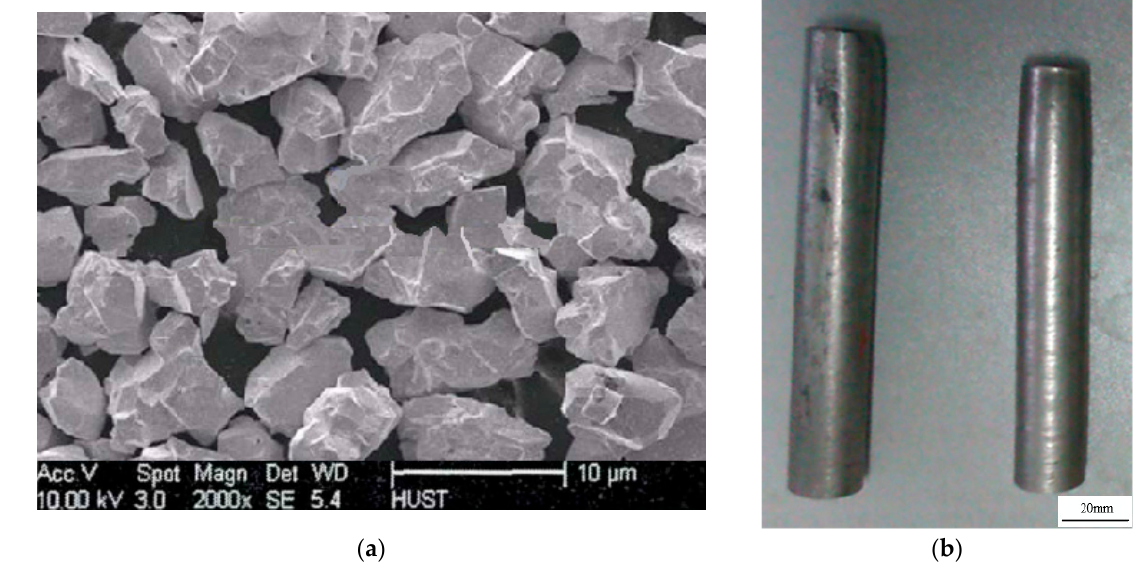
Figure 2. Experimental materials: ( a ) microstructure of tungsten alloy powder materials [19]; ( b ) sintered bars.